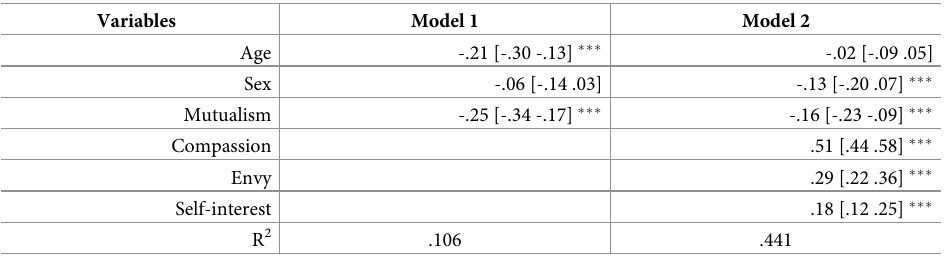
Table 5. Regression models predicting support for